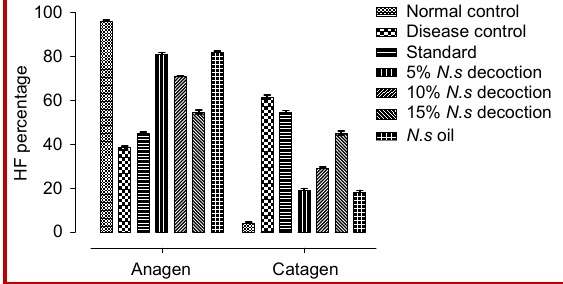
Figure 4: Percentage of hair follicles in either anagen or catagen phase